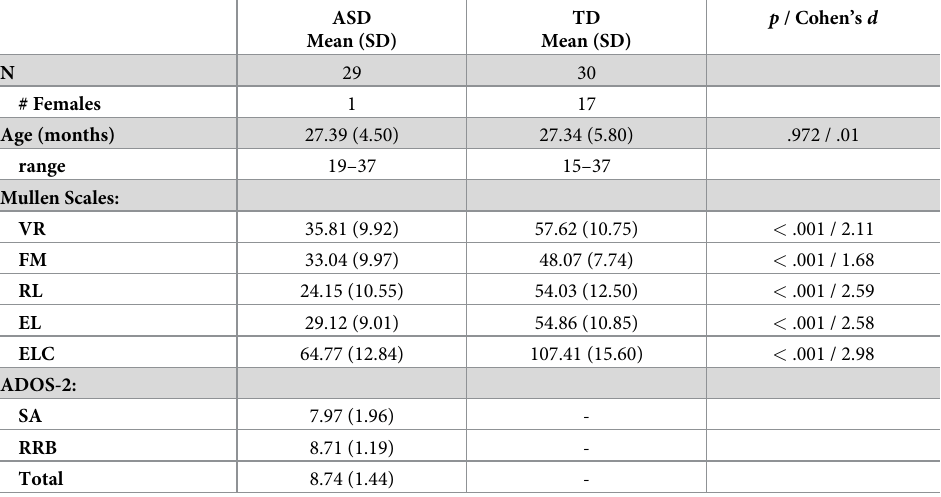
Table 1. Summary of participants’ demographic information and scores on standardized